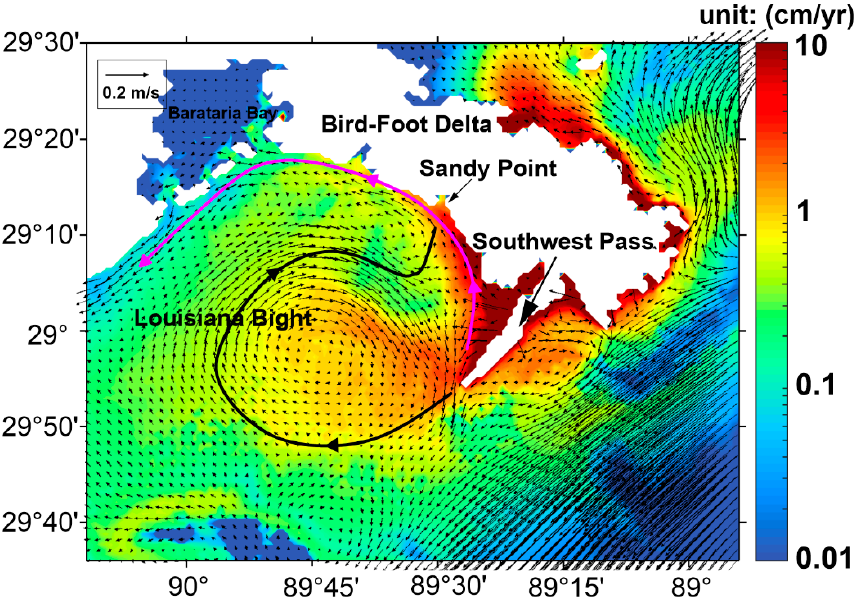
Figure 18. Annual sedimentation rate difference between high and low river scenarios (color) and 20-year averaged barotropic current field in the Louisiana Bight (reddish color represents higher difference between the two scenarios). The black and magenta solid long arrows illustrate two pathways of sediment transport to the mouth of the Barataria Bay.